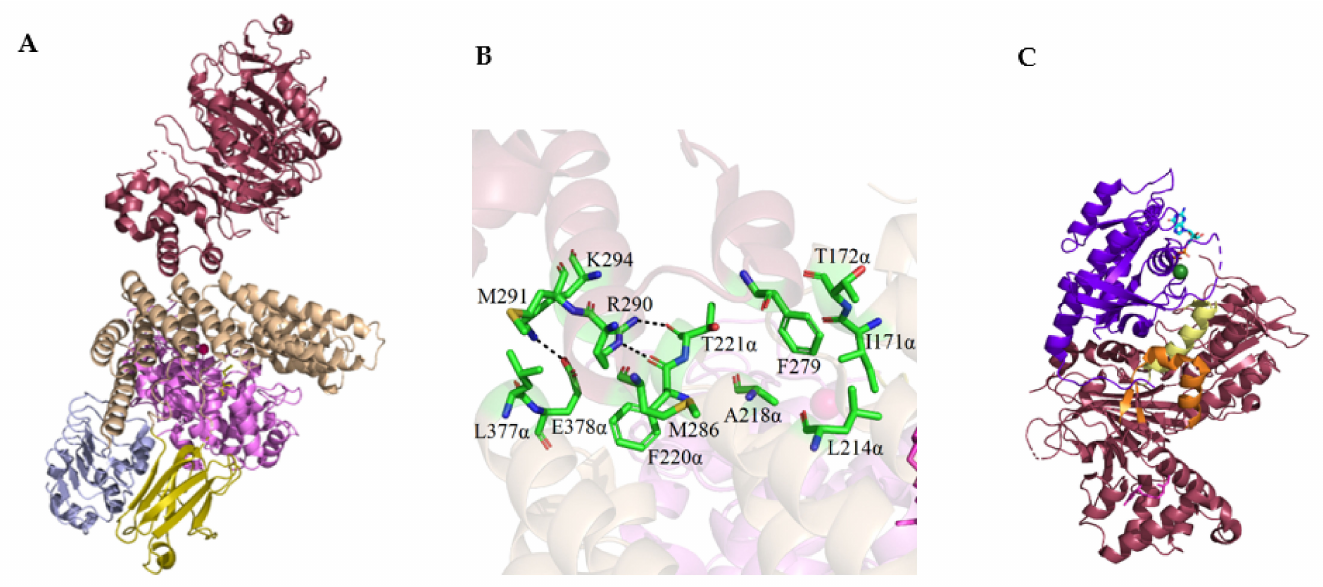
Figure 6. Structure of isoprenoid-bound Rab geranylgeranyl transferase complexed to REP-1 (beige, the α -helical domain; yellow, the Ig-like domain; blue, the LRR domain; pink, the β subunit; red, REP-1) ( A ) (PDB: 1LTX). The phosphoisoprenoid binding pocket of RGGT ( B ). Structure of the REP-1 (yellow, the Rab binding platform RBP; orange, the C-terminus binding region CBR) in complex with monoprenylated Rab7 ( C ) (PDB: 1VG0). (Created in the PyMOL Molecular Graphics System,